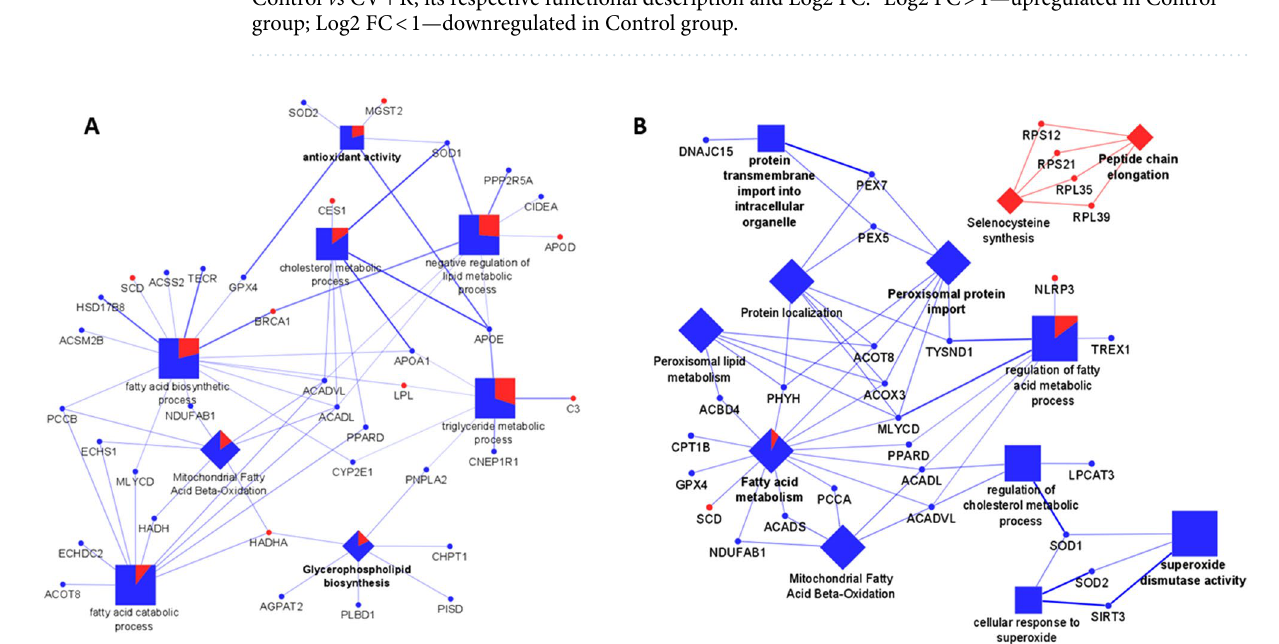
Figure 5. Functional analysis performed with Cytoscape software using the 50 most up and 50 most downregulated genes and genes of interest for ( A ): Control vs CV comparison and ( B ): Control vs CV + R comparison. The significant DEGs and the interactions with their related pathways and biological processes are presented in the figure. Legend: squares = biological processes; diamonds = reactome pathways; circles = DEGs; shape size = according to the p-value of the term in its own group; red colour = upregulated in Control; blue colour = downregulated in